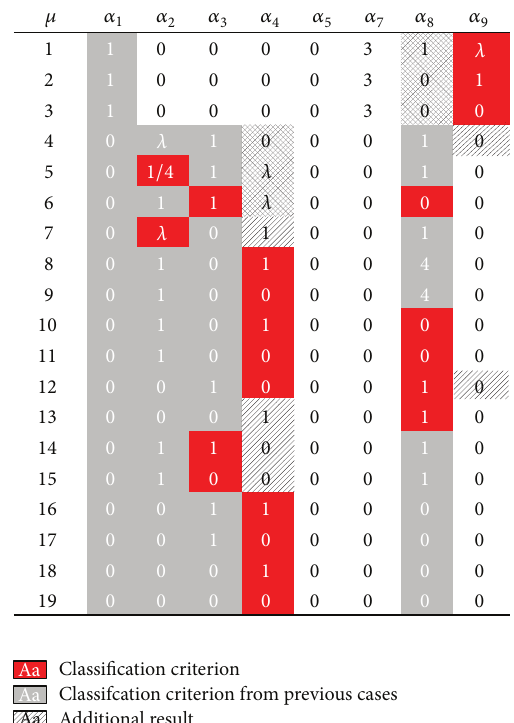
Figure 1: Case A: 𝛼 11 ̸= 0 ; classification of the nonisomorphic QFLA of dimension 9 (the last 7 values, 0, 1, 0, 0,0, 0, 0 , common to the 19 families have been omitted from the figure for